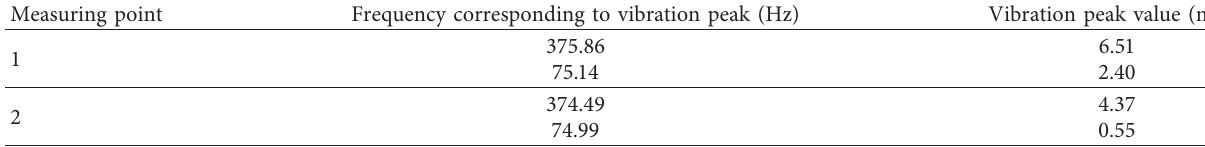
Table 4: Comparative analysis of vibration test results under fixed working condition.